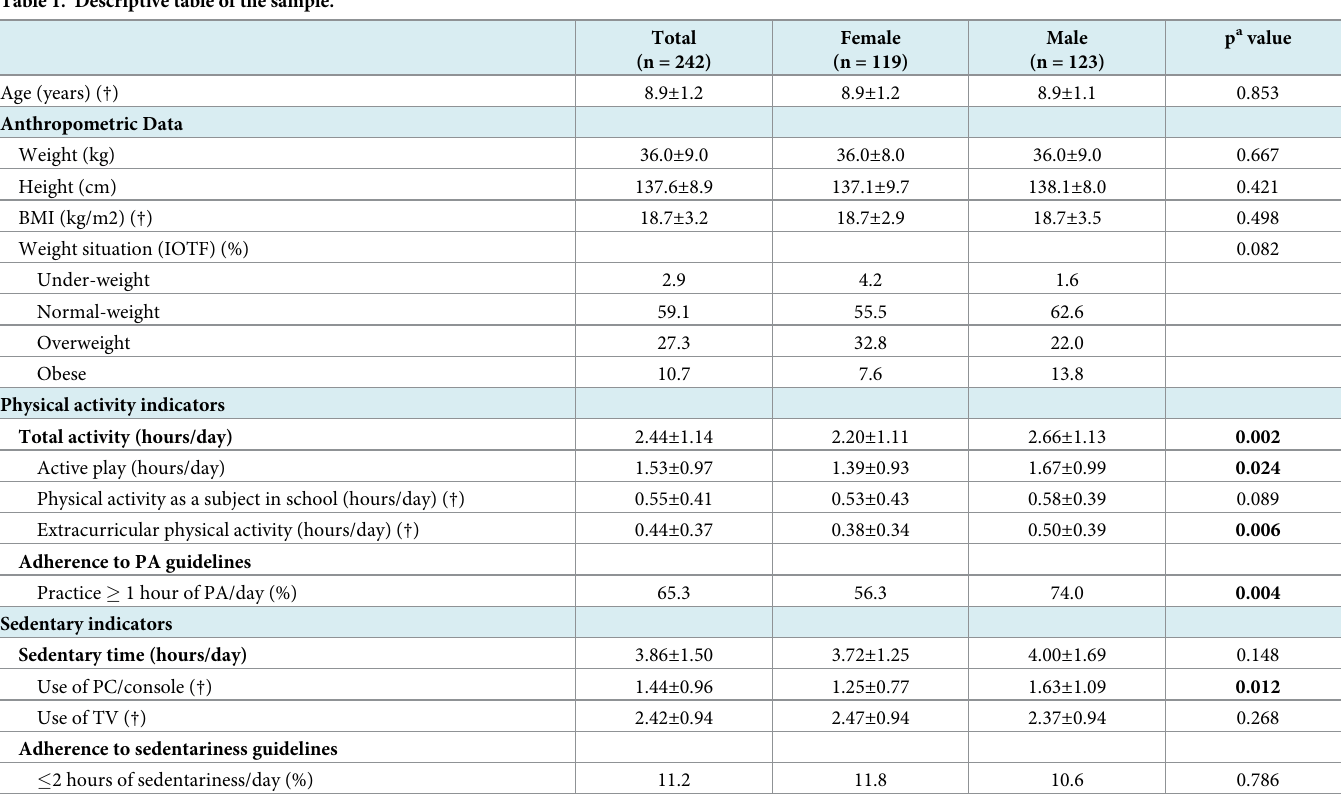
Table 1. Descriptive table of the